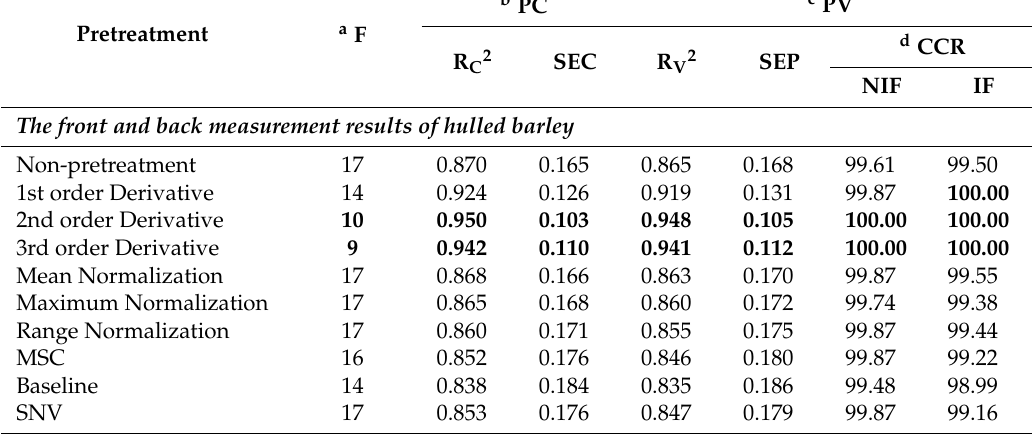
Table 5. Performance of the PLS-DA calibration and validation models for Fusarium -infected hulled barley samples as well as classification accuracy for normal and infected hulled barleys. b Pretreatment a F